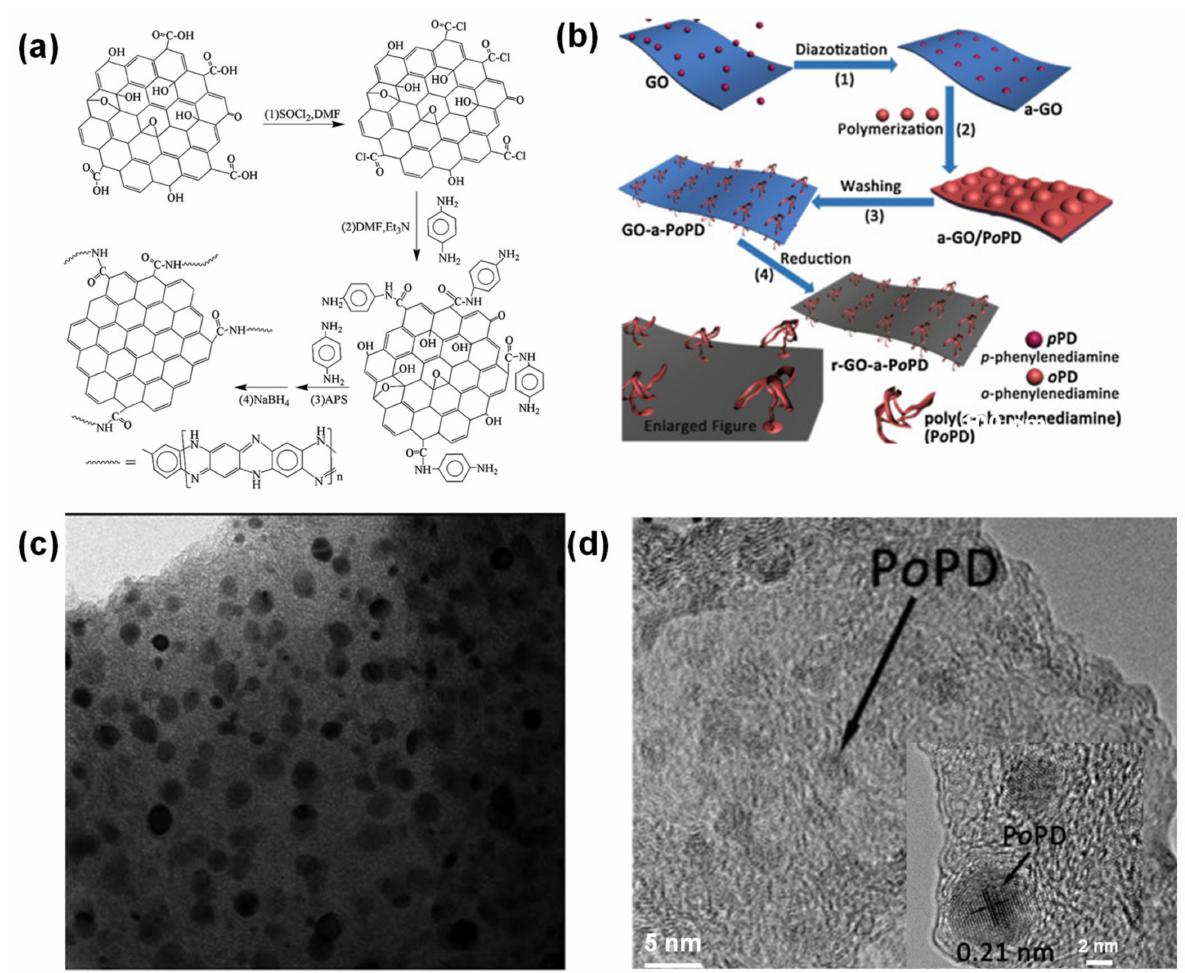
Figure 13. ( a , b ) Mechanism of the covalent functionalization, and ( c , d ) HTEM images of rGO modified poly-p-PD and poly-o-PD quantum dots. Reproduced with permission from Refs.